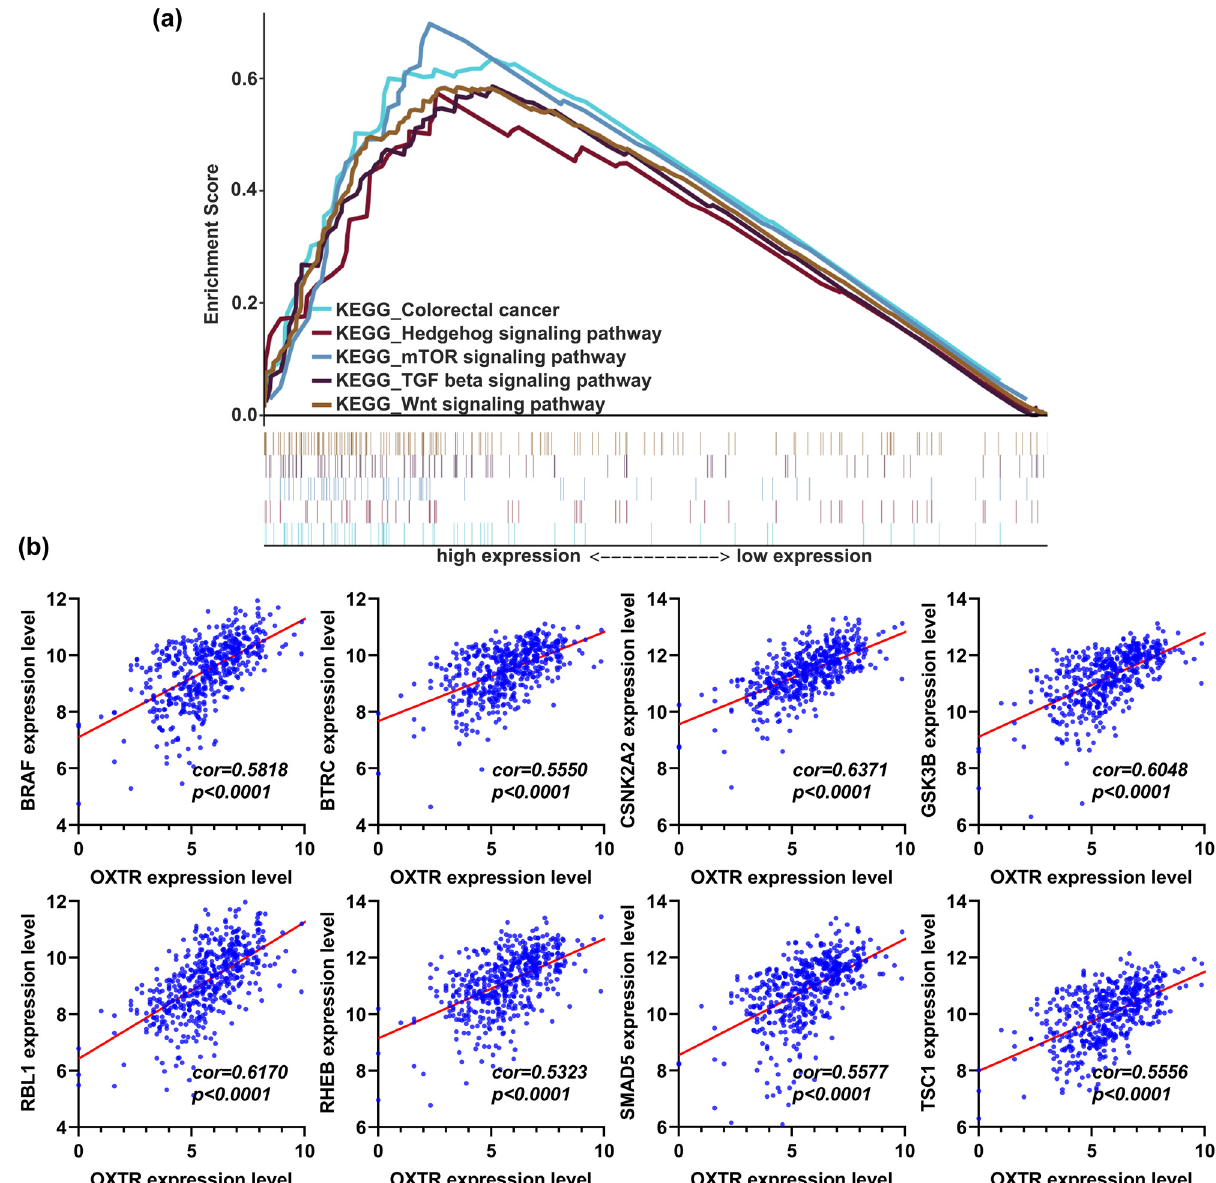
Figure 6: KEGG enrichment analysis of the correlation of OXTR mRNA level with colorectal cancer and four main signaling pathways in colorectal cancer. ( a ) Gene set enrichment analysis of the correlation between OXTR expression level and the expression of genes related to four signaling pathways in colorectal cancer. ( b ) Correlation analysis between the OXTR expression level and mRNA levels of genes related to four signaling pathways in COAD. KEGG: kyoto encyclopedia of genes and